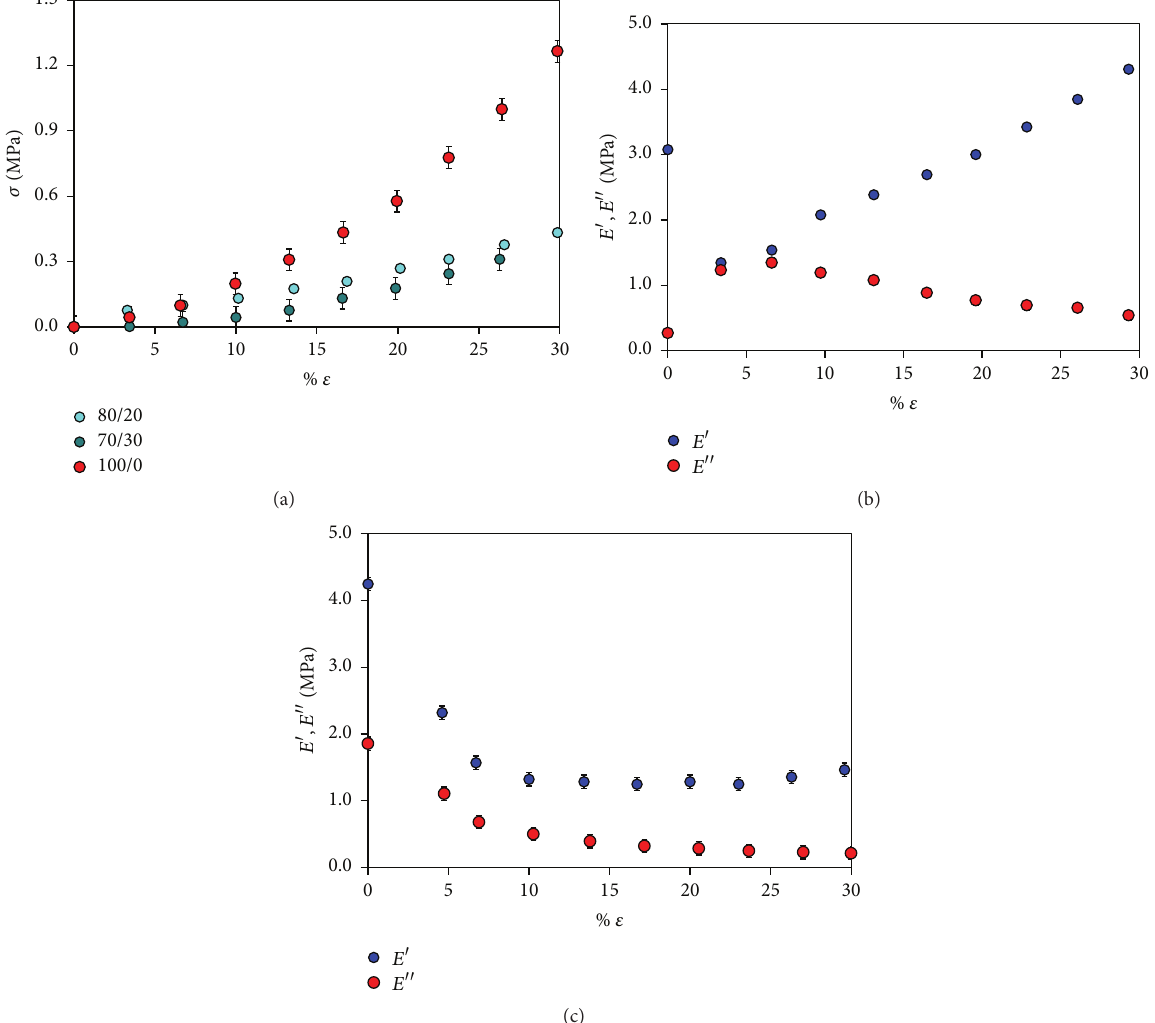
Figure 2: DMA analysis of nonmicrostructured PLGA/gelatin materials. (a) Curve stress-strain for PLGA pure and PLGA/gelatin 70/30 and 80/20 materials; (b) storage and loss modulus as function with deformation for pure PLGA sample; (c) storage and loss modulus as function with deformation for PLGA/gelatin 70/30